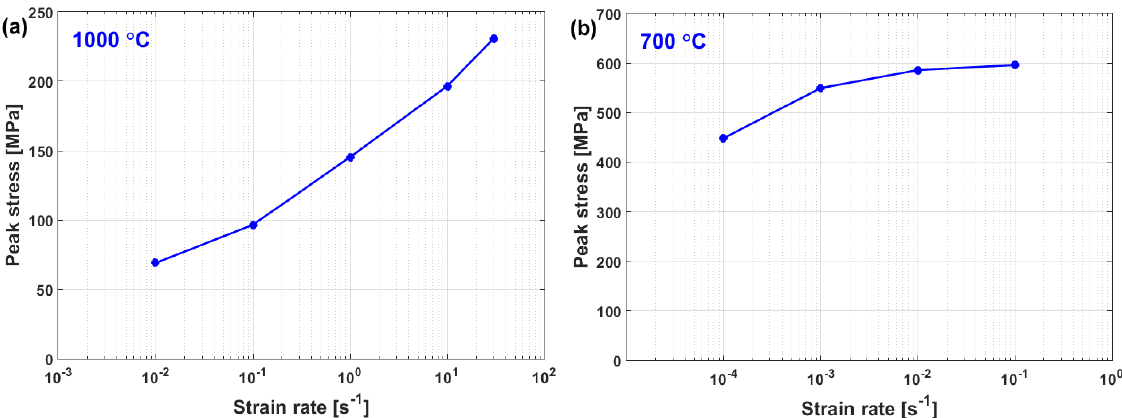
Figure 4. Peak stress vs. strain rate during hot deformation for ( a ) Fe-26Mn-6.2Al-0.05C steel and ( b ) Duplex cast steels.